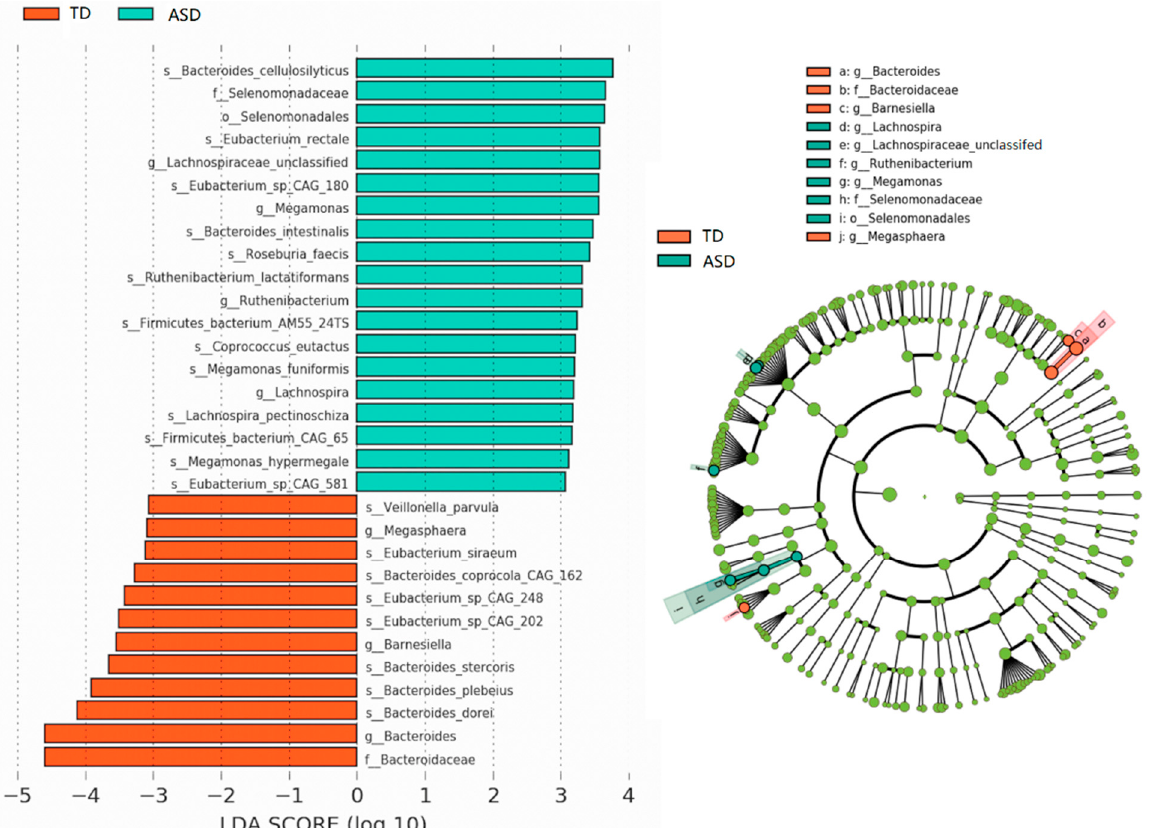
Figure 5. LEfSe analysis. The bar chart ( left ) shows the significantly different species in TD and ASD groups, and the circle chart ( right ) shows the taxonomic rank of the different species from phylum to genus.